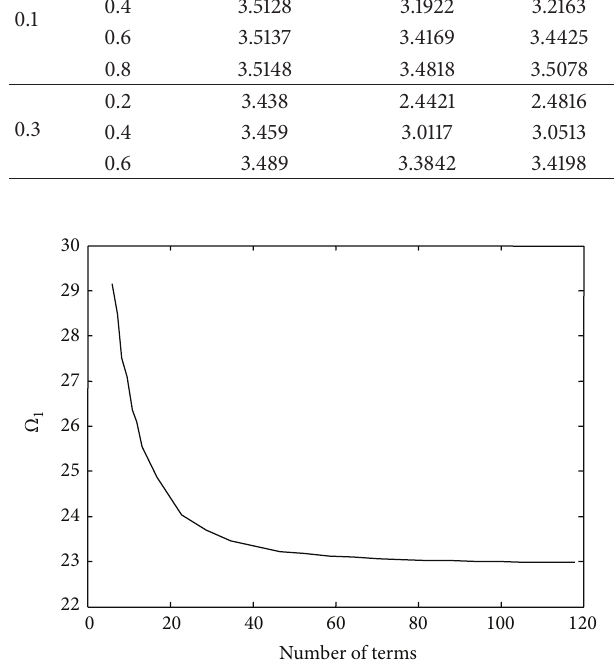
Figure 3: Convergence study for a delaminated Timoshenko beam with I:C-C B.C.s ( 𝐿 1 = 0.3, 𝐿 2 = 0.4, 𝐻 2 = 0.5, and 𝐿/𝐻 1 = 10